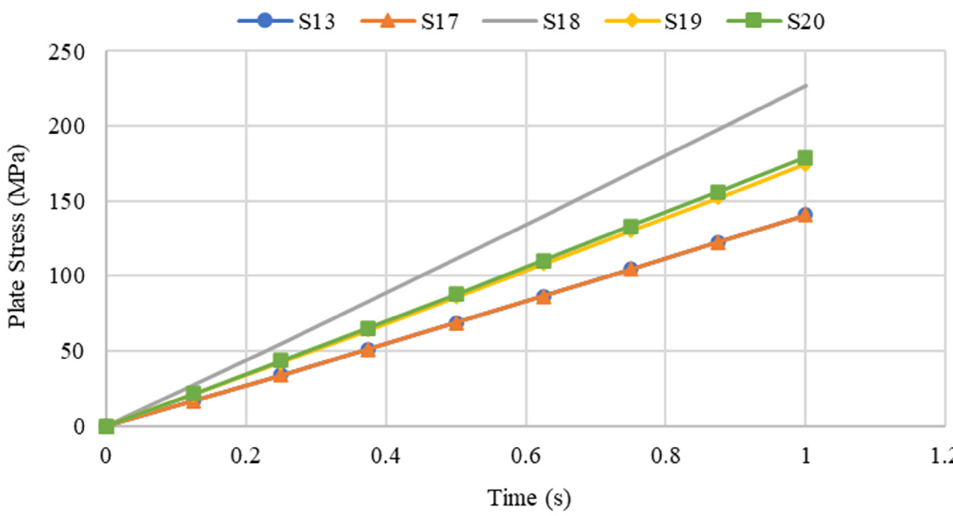
Figure 22. Variation in maximum stress of steel plate specimens with differing plate opening positions. Meticulous analysis and evaluation of the stress contours of the steel plate specimens with differing opening positions and configurations, as displayed in Figure 23, show that every plate specimen had its own unique stress distribution contour portraying the stress distribution of the applied load throughout the plate surface. Plate specimens S-13 and S-17 had common stress and displacement values, but their stress distribution contour areas differed from one